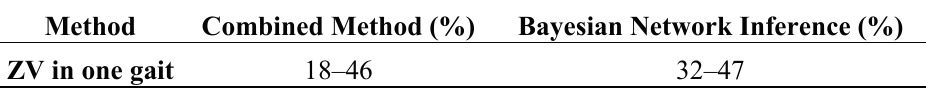
Table 1. The proportion of detected ZV period in one gait cycle by two